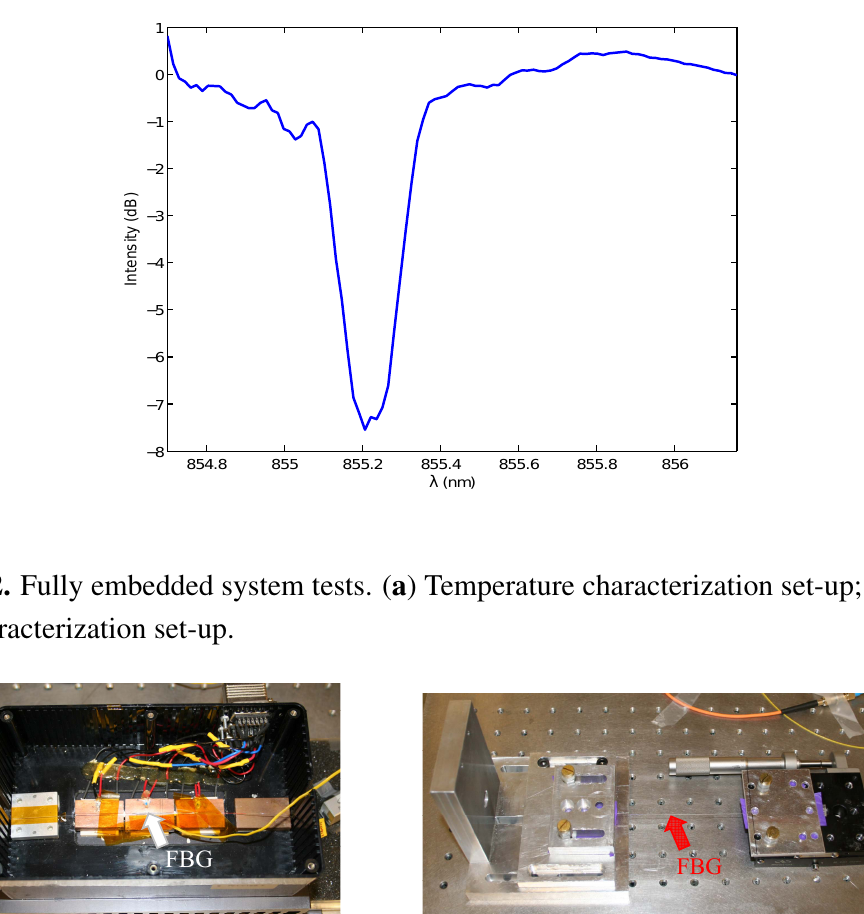
Figure 11. Full spectral FBG reconstruction using integrated VCSEL and photodetector.